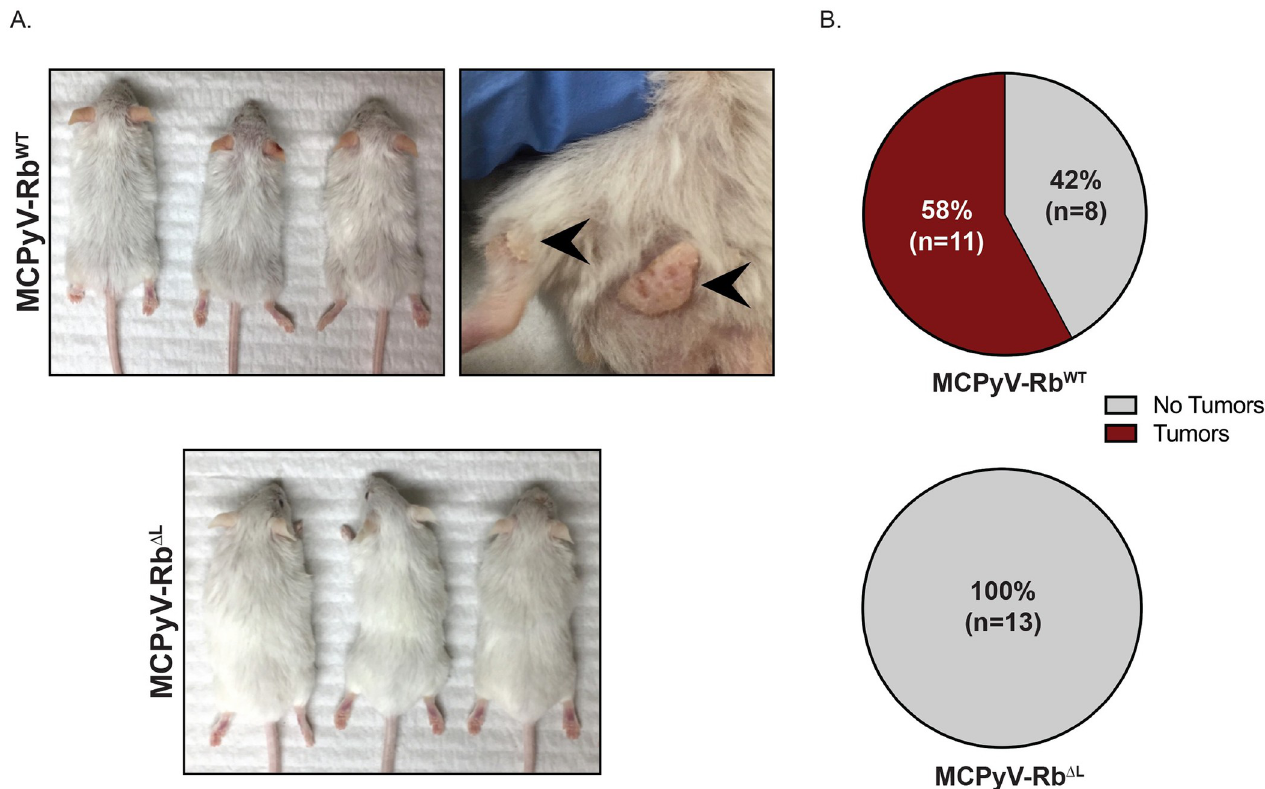
Fig 4. The interaction between pRb and the MCPyV large T antigen is required for spontaneous tumor development in murine skin. A) Representative images of MCPyV-Rb WT (top) and MCPyV-Rb Δ L (bottom) mice on the FVB/N genetic background at 6 months of age. The black arrowheads highlight two representative spontaneous skin tumors arising on the skin of MCPyV-Rb WT mice. All photographs were taken at the same distance from each subject and therefore reflect the same magnitude. B) Pie charts indicate spontaneous tumor incidence in the skin of MCPyV-Rb WT (top) and MCPyV-Rb Δ L (bottom) mice on the FVB/N genetic background that developed over the course of 6 months. The number of mice in each condition is shown in parentheses.